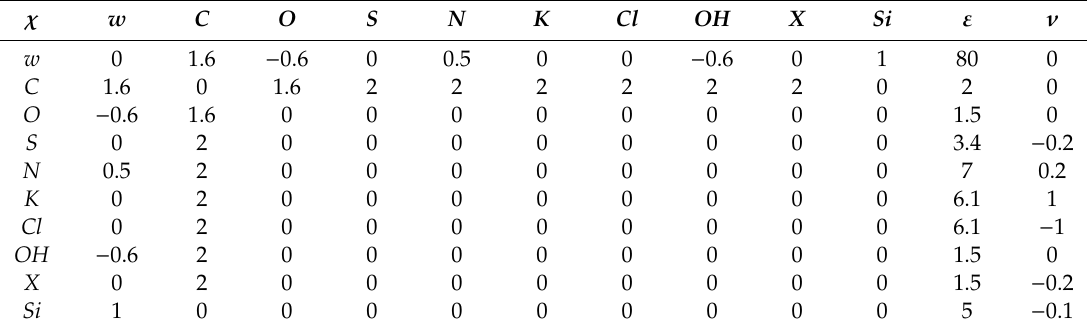
Table 1. Flory–Huggins interaction parameters, χ , between various pairs of segments, relative dielectric constant, ε , and valence, ν , of the segment types, as used in the SCF calculations. Note that the segment type X denotes the deprotonated segment of a carboxylic group, and Si and w denote the surface and the water,